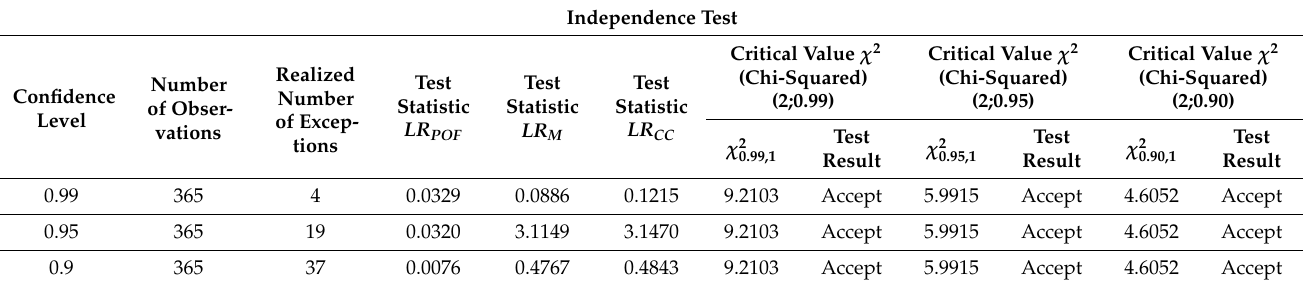
Table 5. Historical simulation Christoffersen’s Interval Forecast